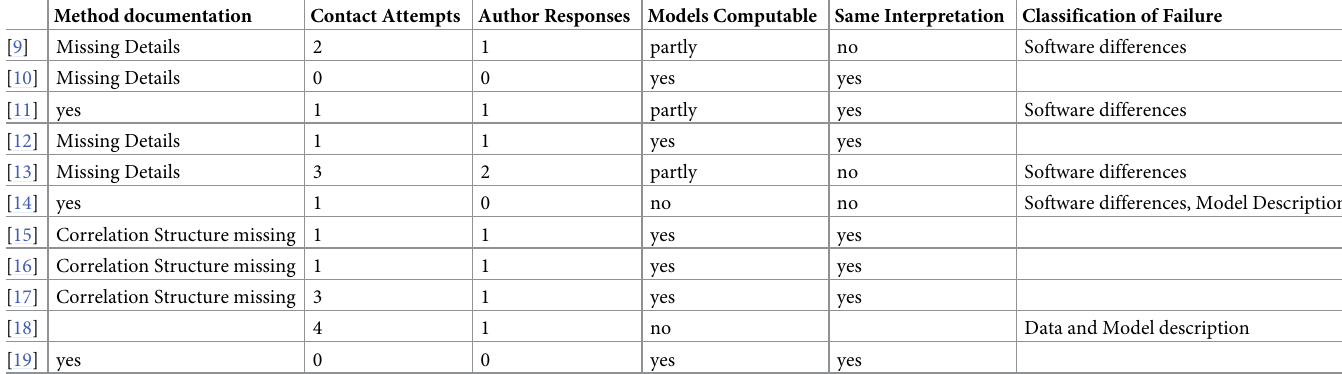
Table 4. Were the results